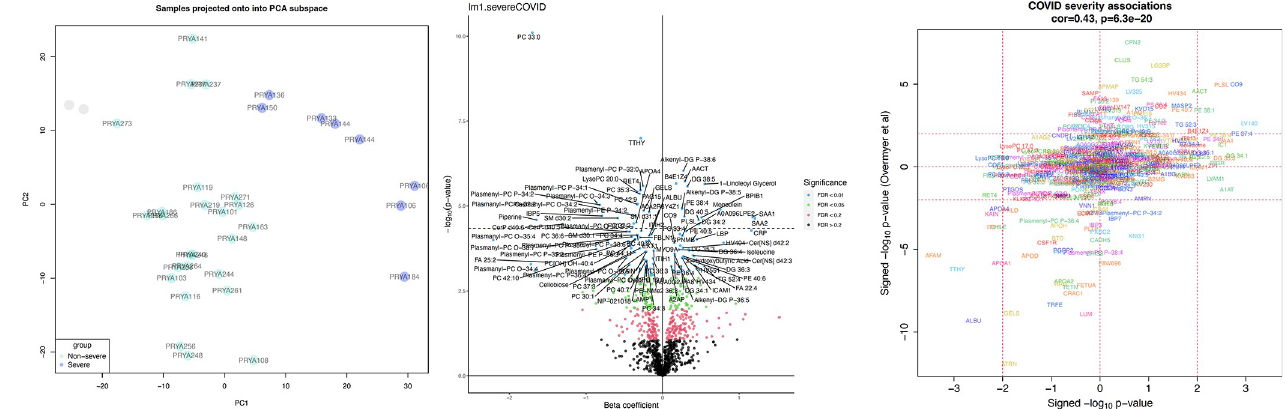
Fig 1. a. Principal components analysis showing clear separation of severe COVID-19 cases versus all others. b. Volcano plot illustrating proteins altered in severe SARS-CoV-2 positive pregnancies. c. COVID-19 severity associations.